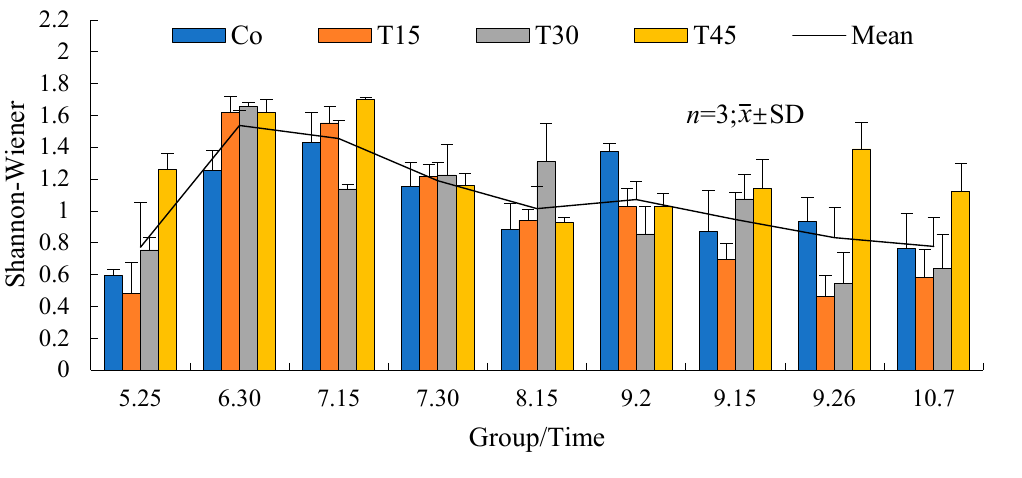
Figure 5. Shannon–Wiener diversity distribution indexes in different treatment groups during the experiment.